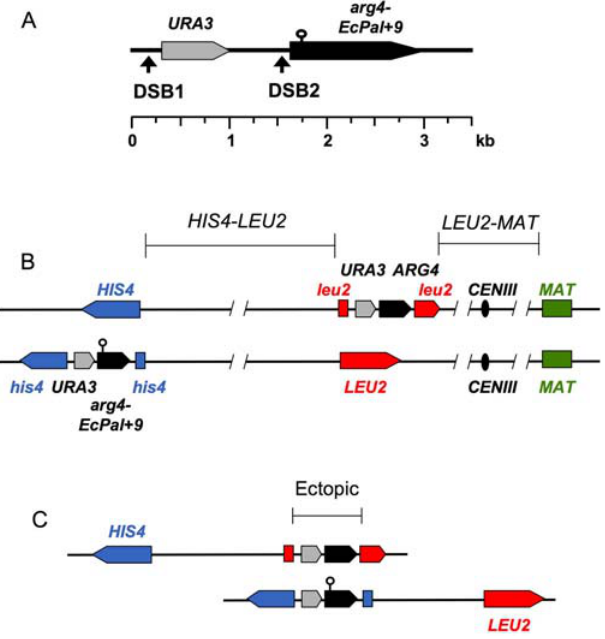
Figure 1. Recombination Interval Used for Molecular Analyses (A) The 3.5-kilobase ectopic recombination interval contains coding sequences for URA3 (gray) and ARG4 (black). DSBs form in the promoter regions of URA3 (DSB1) and ARG4 (DSB2). The lollipop in arg4 represents a palindromic sequence inserted at þ 9 of the open reading frame; this mutation is used to score gene conversion [16]. (B) The ectopic recombination interval is inserted at HIS4 (blue) on one copy of Chromosome III and at LEU2 (red) on the homolog. HIS4 and LEU2 are 16.7 kilobases apart. In rad50S strains, where DSBs persist, 5% of chromosomes have a DSB in his4::URA3-ARG4 and 0.7% have a DSB in leu2::URA3-ARG4 [16]. The centromere (black circle) and MAT locus (green) are also indicated. Allelic COs can be scored in the HIS4-LEU2 and LEU2-MAT intervals. (C) Ectopic COs can occur between his4::URA3-ARG4 and leu2::URA3- ARG4 . DOI: 10.1371/journal.pgen.0020155.g001